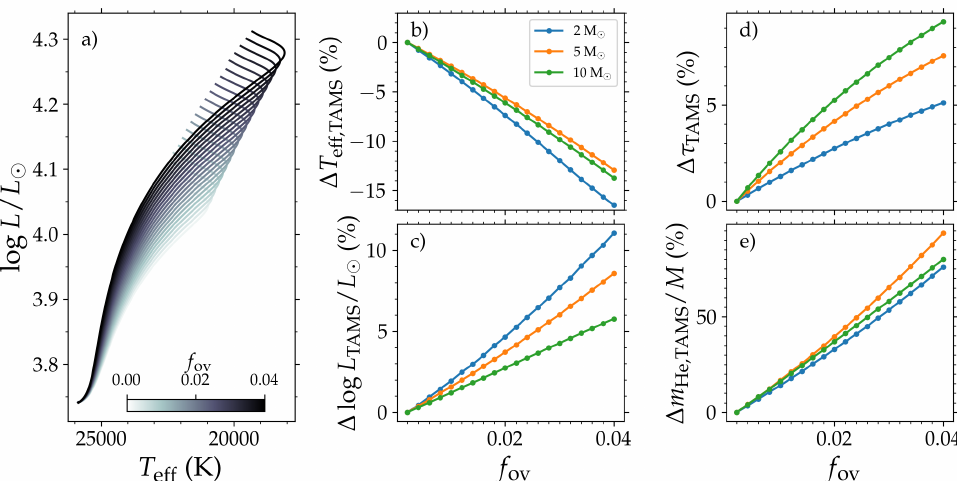
Figure 1. Illustration of the effect of increasing the size of the CBM region assuming exponential diffusive overshoot. ( a ) HR diagram showing the evolutionary tracks for a 10M extents of the CBM region. f ov = 0.002 is a low value, whereas f ov = 0.04 is considered a high value for this parameter. ( b ) Percentage change in the effective temperature at the TAMS compared to the f ov = 0.002 case for three different initial masses. The f ov parameter sets the extent of the CBM region and how rapidly the mixing decreases with distance from the convective core boundary; see Section 2.4. ( c ) Same as ( b ) but for the luminosity at the TAMS. ( d ) Same as ( b ) but for the age at the TAMS. ( e ) Same as ( b ) but for the helium core mass obtained at the TAMS. Figure made by the authors using MESA models. MESA inlists and data used to generate the figure are available on Zenodo